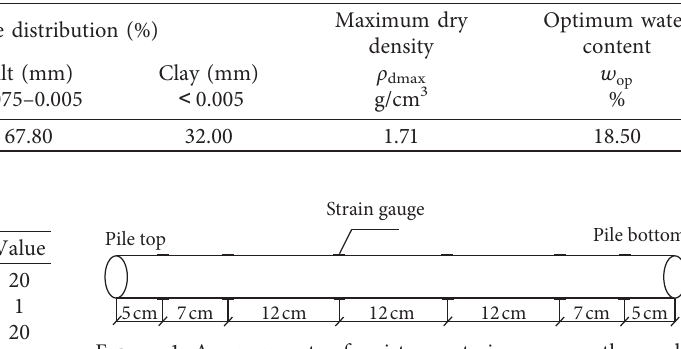
Table 1: Physical parameters of Yangling loess in this model test.